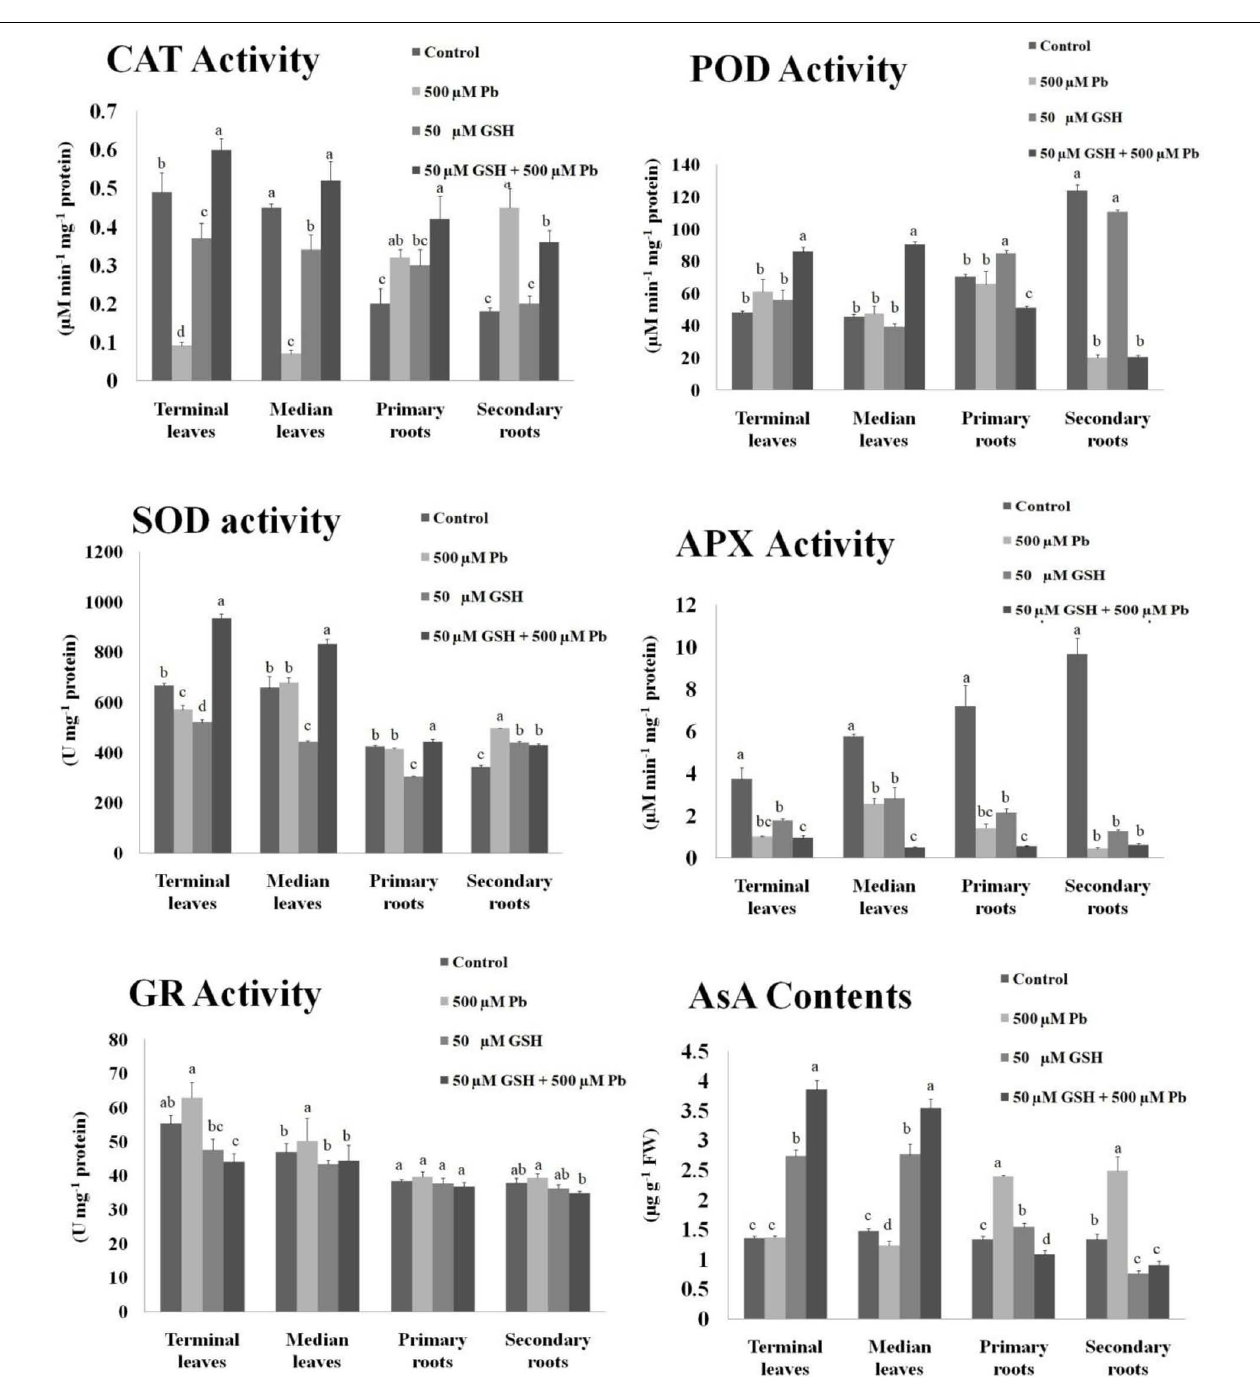
FIGURE 1 | Antioxidant activities in upland cotton under Pb and GSH applications. Response of catalase (CAT), peroxidase (POD), superoxide dismutase (SOD), ascorbate peroxidase (APX), glutathione reductase (GR) and ascorbic acid (AsA) in cotton leaves and roots exposed for 10 days to Pb and GSH in Hoagland solution. Same alphabets on bars represent no significance at 5% probability according to Duncan’s multiple range test. Values are mean ± standard deviation (SD) obtained from three independent biological replicates.